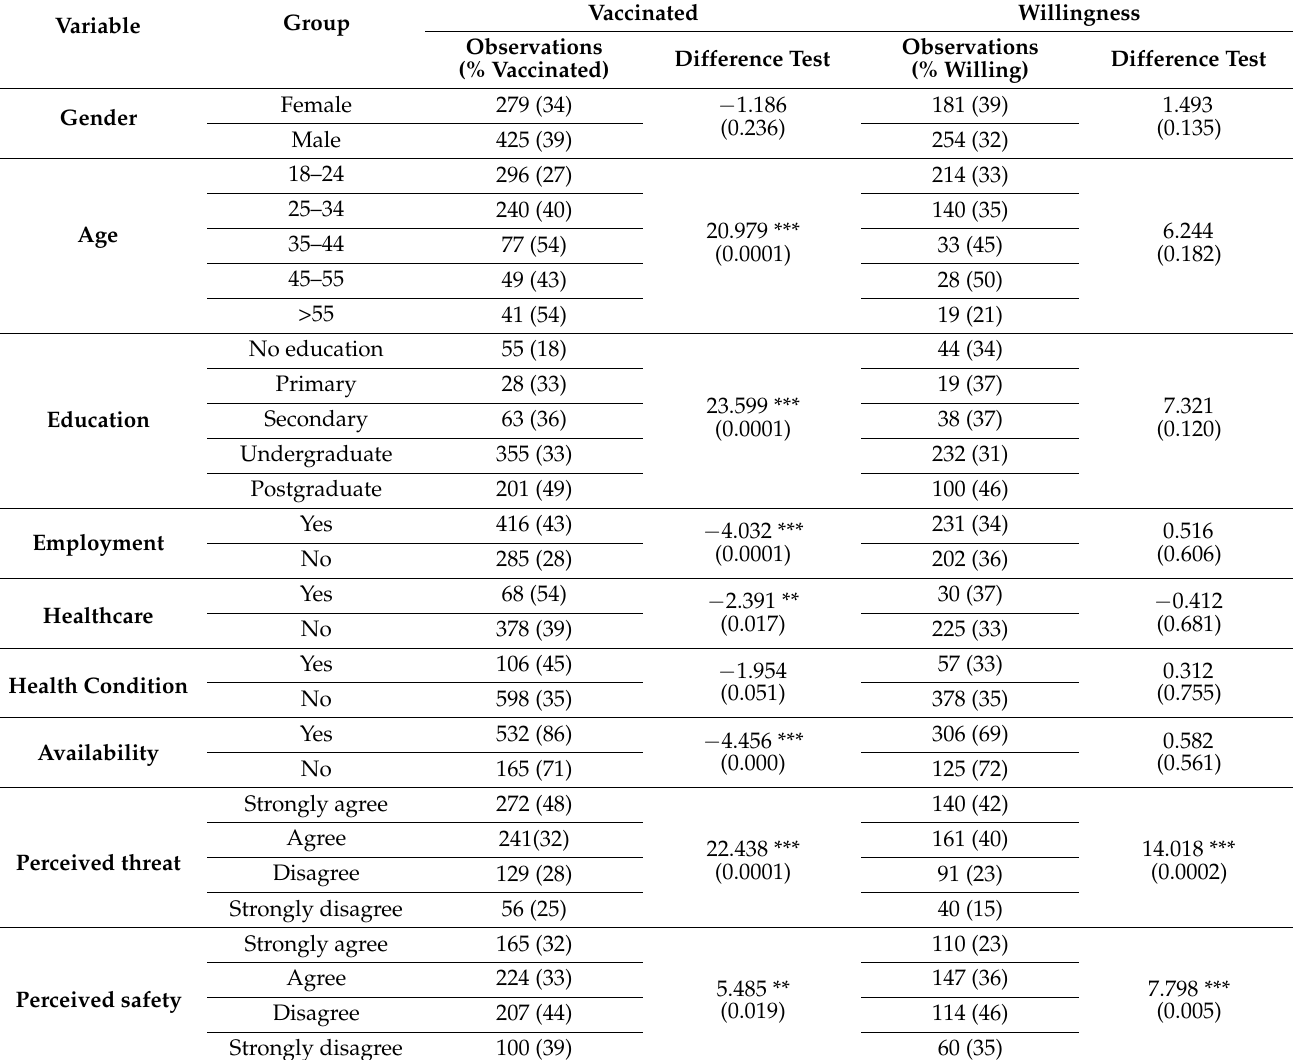
Table 2. Group comparison